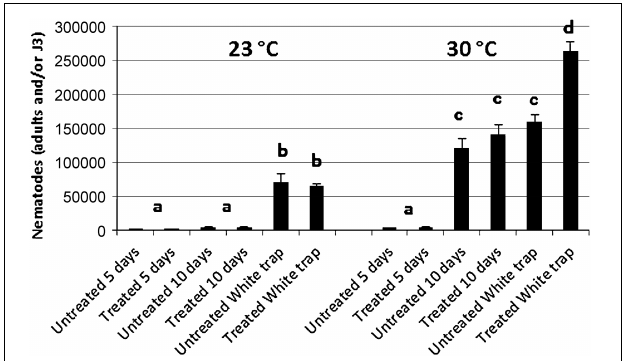
FIGURE 10 | Number of adults and/or Infective Juveniles recovered from Galleria mellonella larvae after 5 and 10 days from infection with treated and untreated Infective Juveniles (IJs) at 23 and 30 ◦ C. Bars with the same letter have no significant differences ( P < 0.05).